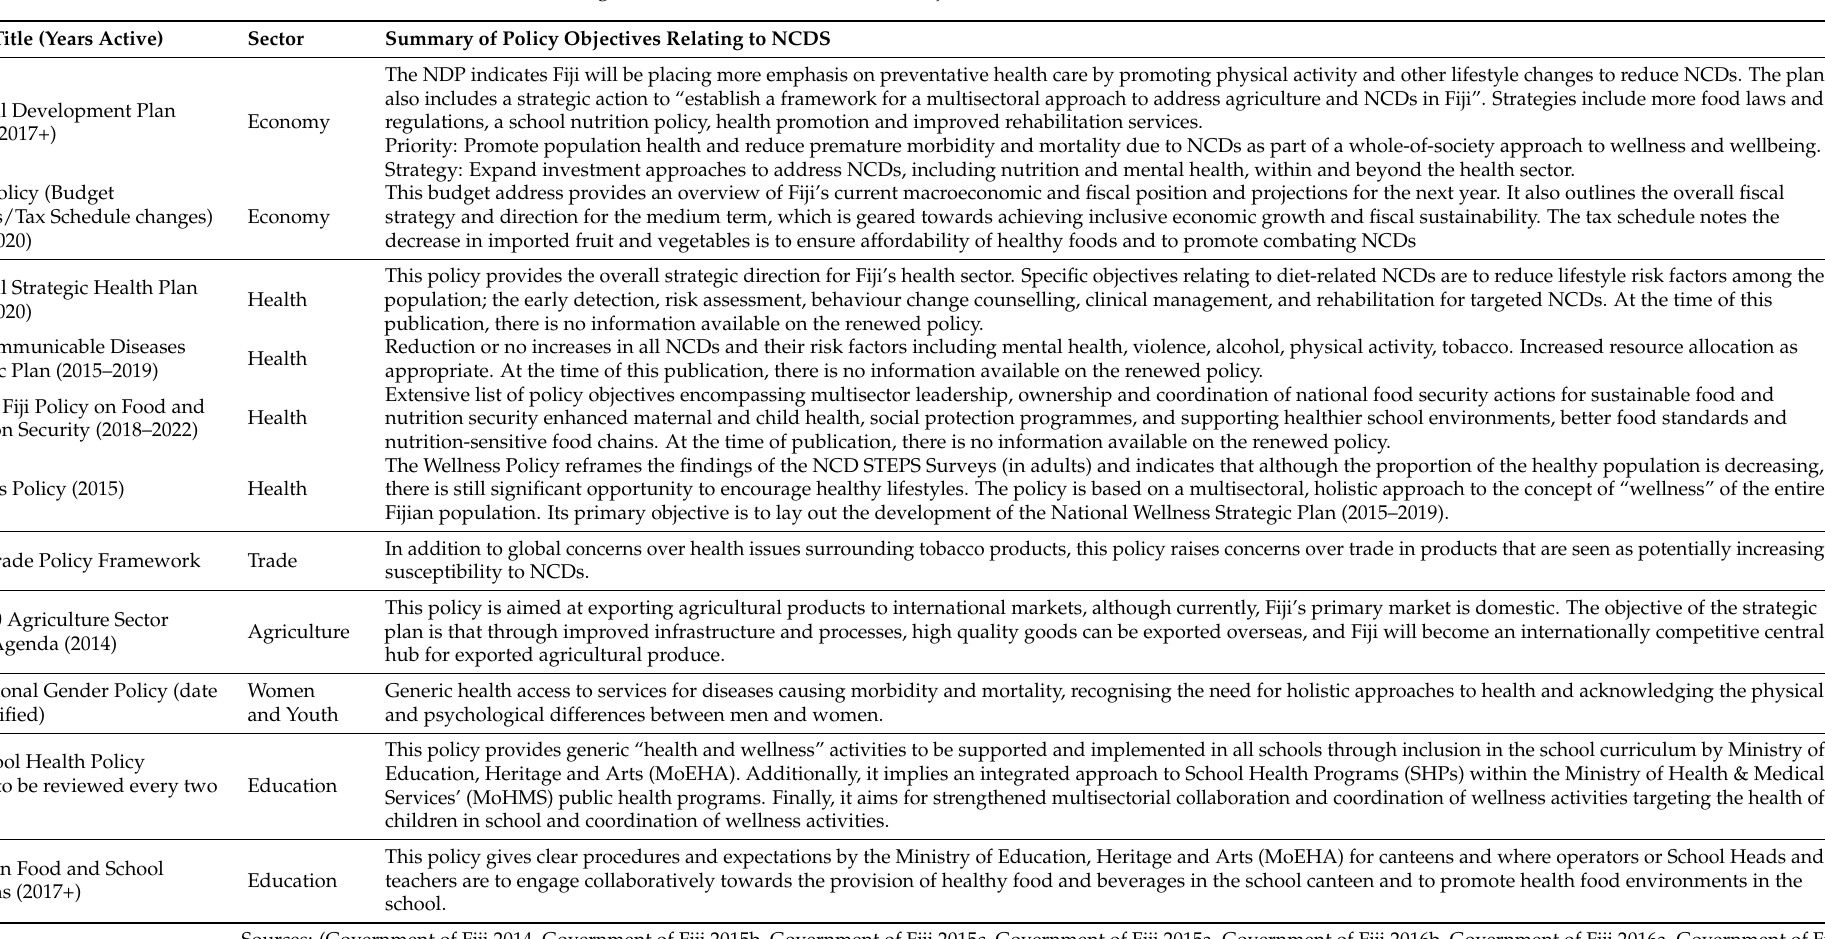
Table A1. Policies Identified Relating to NCD Prevention Actions in